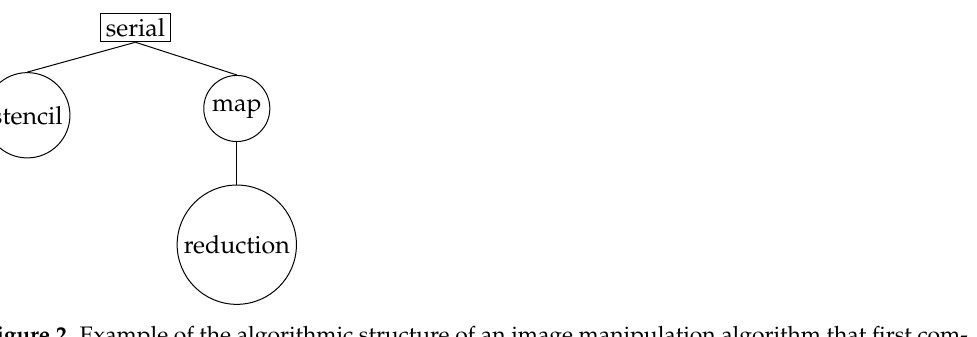
Figure 2. Example of the algorithmic structure of an image manipulation algorithm that first com- putes the image gradients and then applies a 1D-filter to the